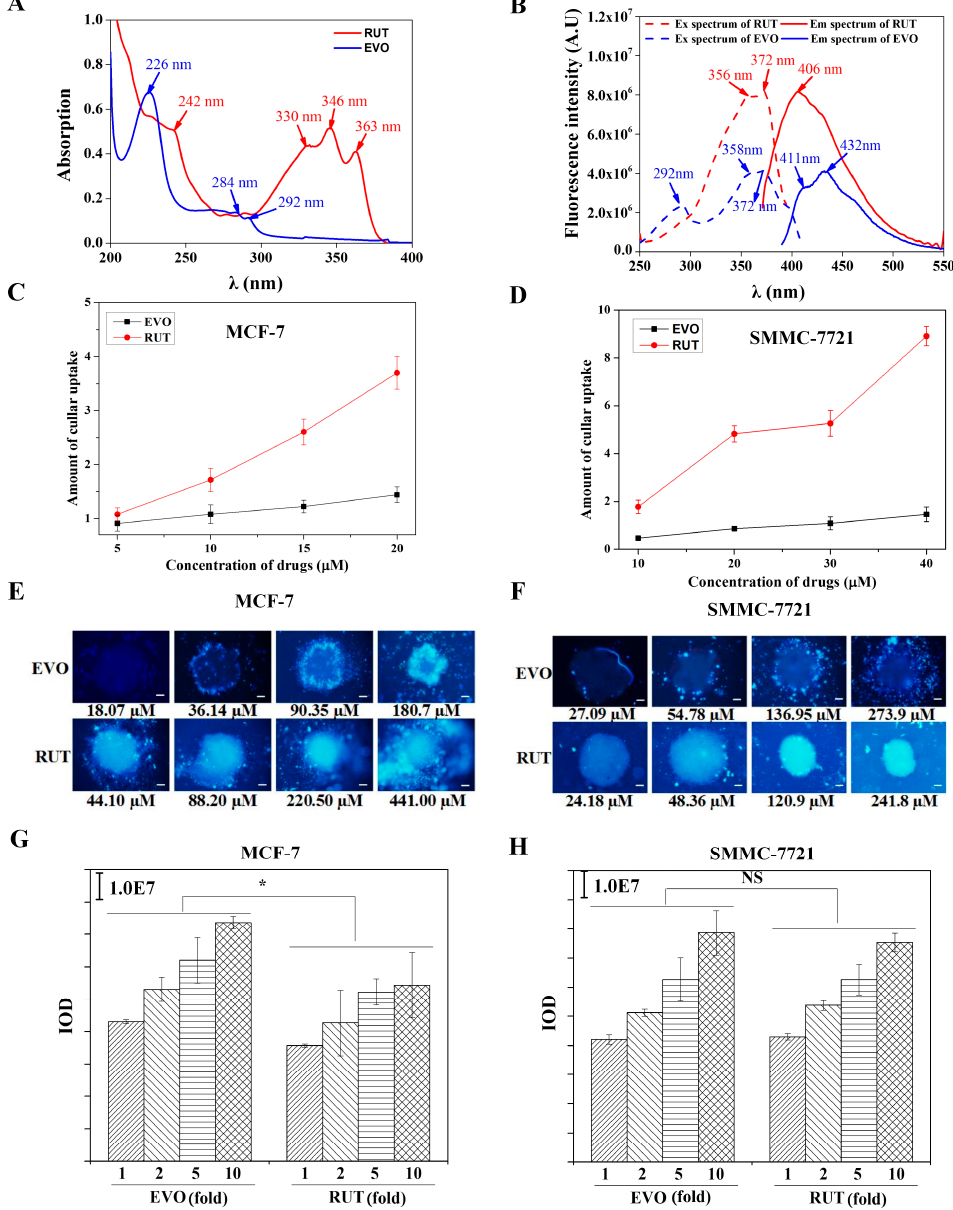
Figure 4. The model drugs, the spectrum characteristics of EVO and RUT and the cellular uptake of the drugs in vitro tumor models. ( A ) UV spectrum of RUT (red line) and EVO (blue line) in CH 3 CH 2 OH (1.0 × 10 − 5 M); ( B ) The fluorescence spectrum of RUT (red line) and EVO (blue line) in CH 3 CH 2 OH (1.0 × 10 − 5 M); The amount of cellular uptake after treatment with the different concentrations of the two drugs in ( C ) MCF-7 and ( D ) SMMC-7721 cells in 2D models; The fluorescence images of 3D ( E ) MCF-7 and ( F ) SMMC-7721 spheroid cultures after treatment with the different drug concentrations measured by fluorescence microscopy. The fluorescence intensity of ( G ) MCF-7 and ( H ) SMMC-7721 cell spheroids by fluorescence microscopy images of the drugs. The results are expressed as means ± SD of six independent experiments. * p < 0.05 EVO versus RUT for MCF-7; NS: EVO versus RUT for SMMC-7721. (* p < 0.05, NS: no significance).